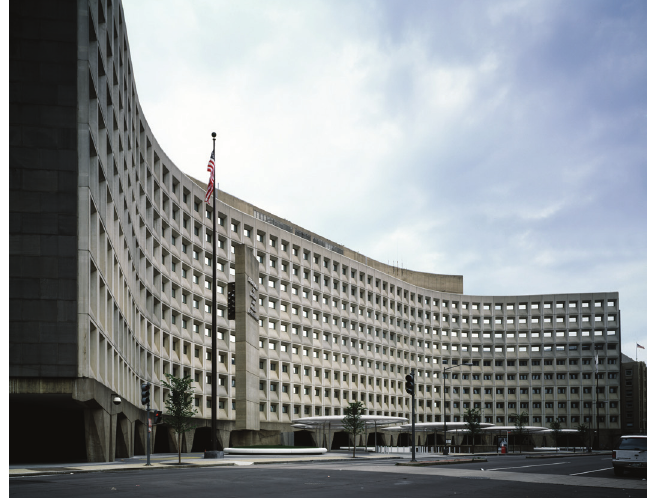
Figure 6 Photographs in